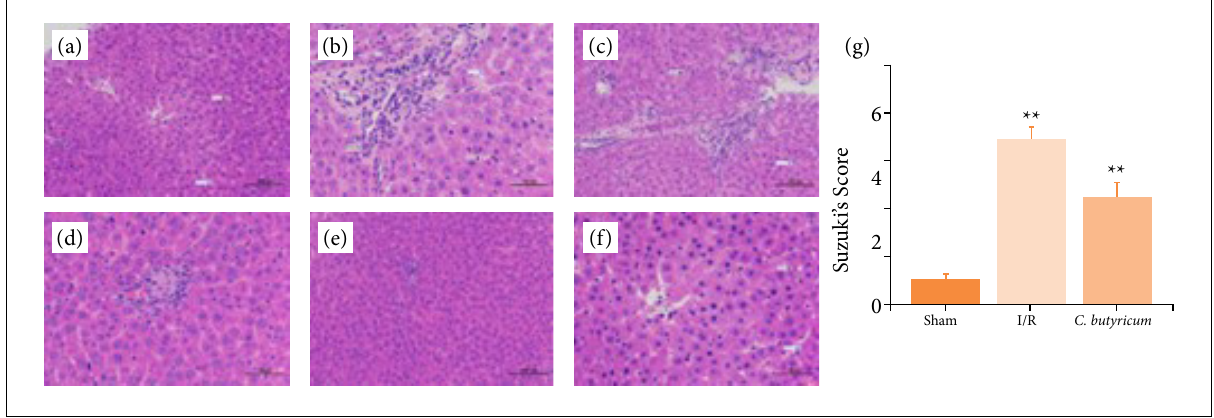
Figure 2 - Histopathology photographs of hepatic tissue in the expe,rimental groups. Sham group: (a) 200× and (b) 400×, Liver parenchyma showed normal structure. I/R group: (c) 200× and (d) 400×. C. butyricum group: (e) 200× and (f) 400×. H&E stain, inflammatory infiltrate (black hollow arrow), cytoplasmic vacuolization (solid black arrow), liver necrosis (blue arrow). (g) Suzuki’s scores of hepatic tissue in the experimental